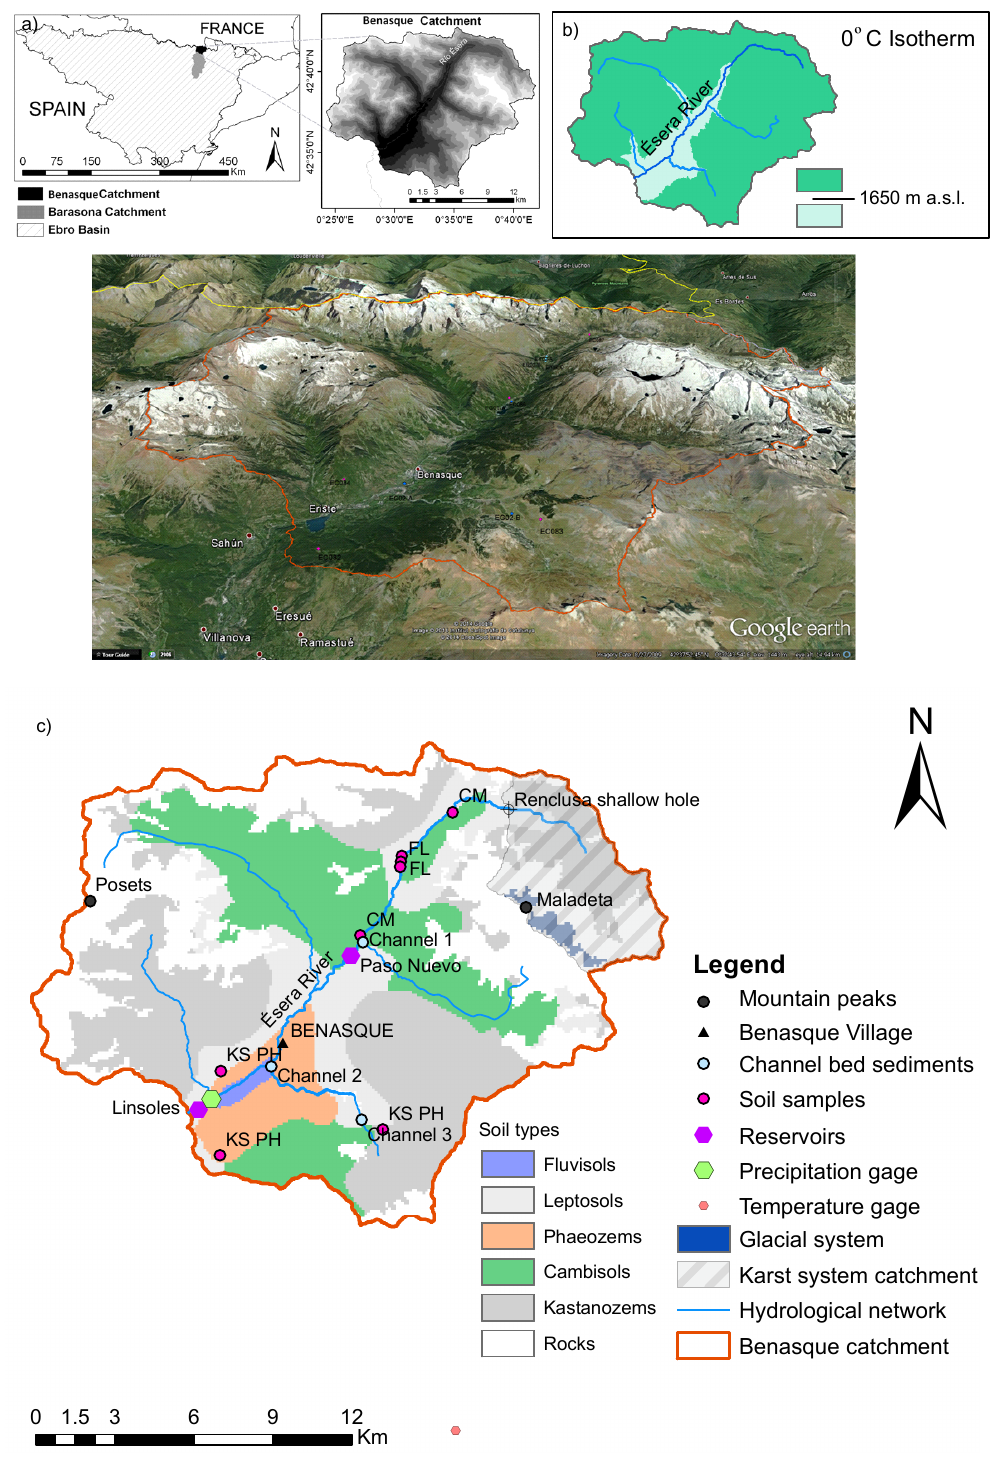
Figure 1. Location of the Benasque catchment (a) . Map of the 0 ◦ C isotherm (b) . Distribution of soil and sediment samples, climate stations, the Paso Nuevo and Linsoles reservoirs (c)